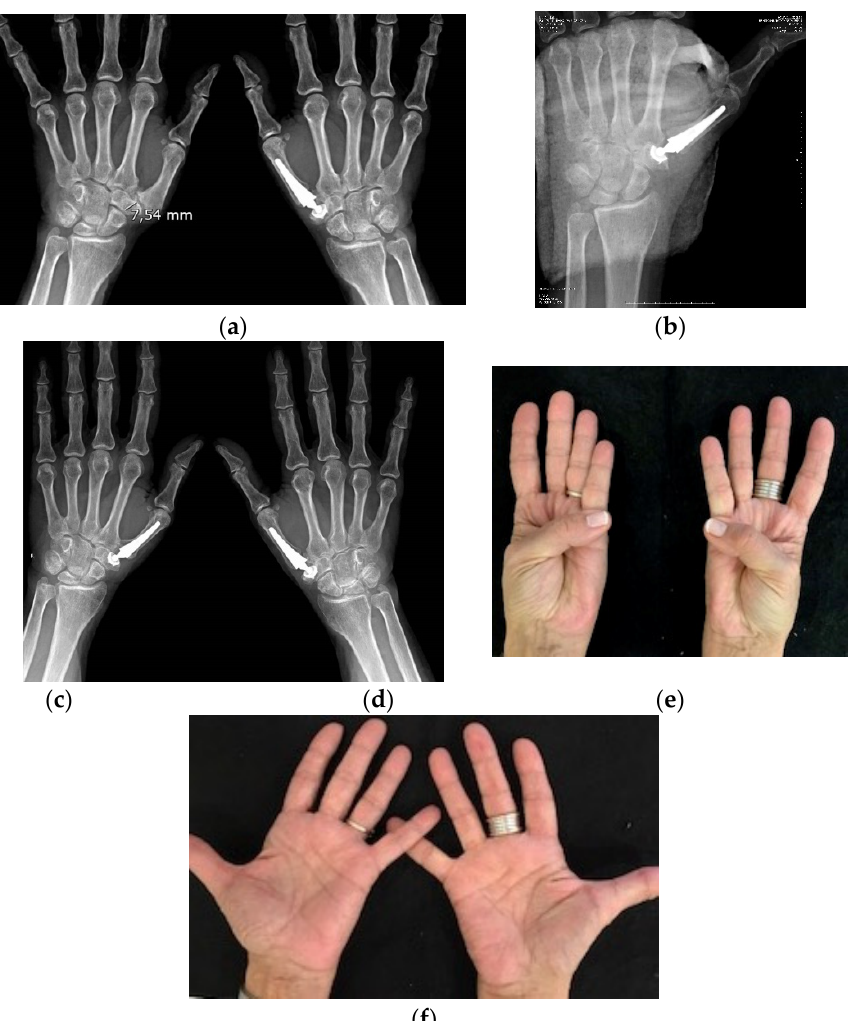
Figure 2. ( a ) 67 year-old patient with bilateral trapeziometacarpal arthrosis. She has had an Arpe prosthesis on the right side for four years. She underwent surgery for prosthesis placement on the left side, where a small trapezium of 7.5 mm was observed; ( b ) Postoperative X-ray control. In a small trapezium there is enough space to place a cup with certainty if good planning and surgical technique are used; ( c , d ) AP and oblique X-ray control of both hands with 11 years of evolution on the left side and 15 years of evolution on the right side; ( e , f ) Thumb mobility at the last follow-up.